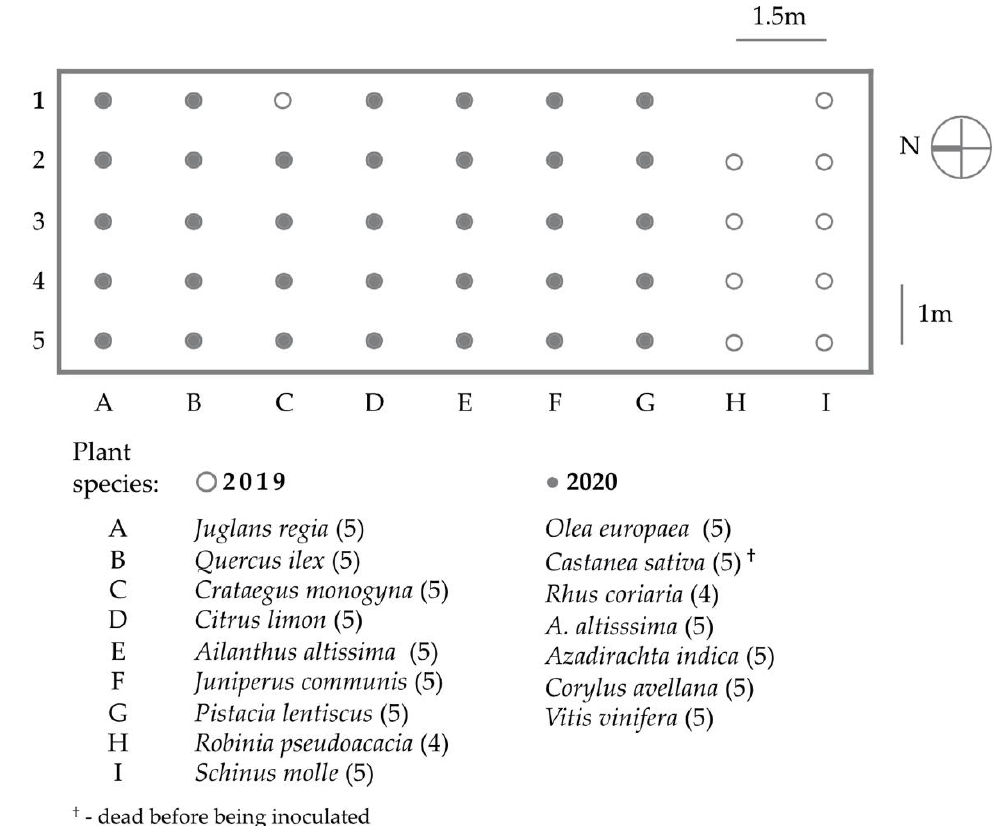
Figure 1. Map of the garden plot setup for target, Ailanthus altissima , and nontarget plants inoculated with Aculus mosoniensis during host-specificity tests performed in 2019 and 2020, respectively. The number of replicates for each species is reported in brackets.